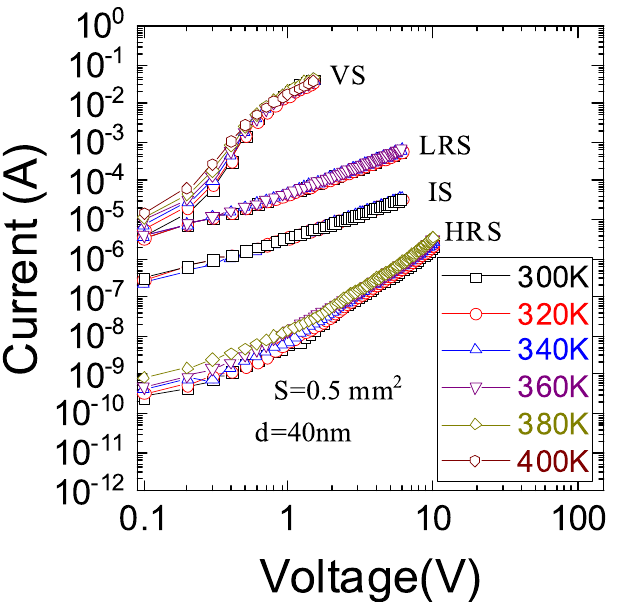
Figure 4. I–V characteristics of p + -Si/SiN x /Ni in VS, IRS, LRS and HRS at different temperatures in a double logarithmic scale.